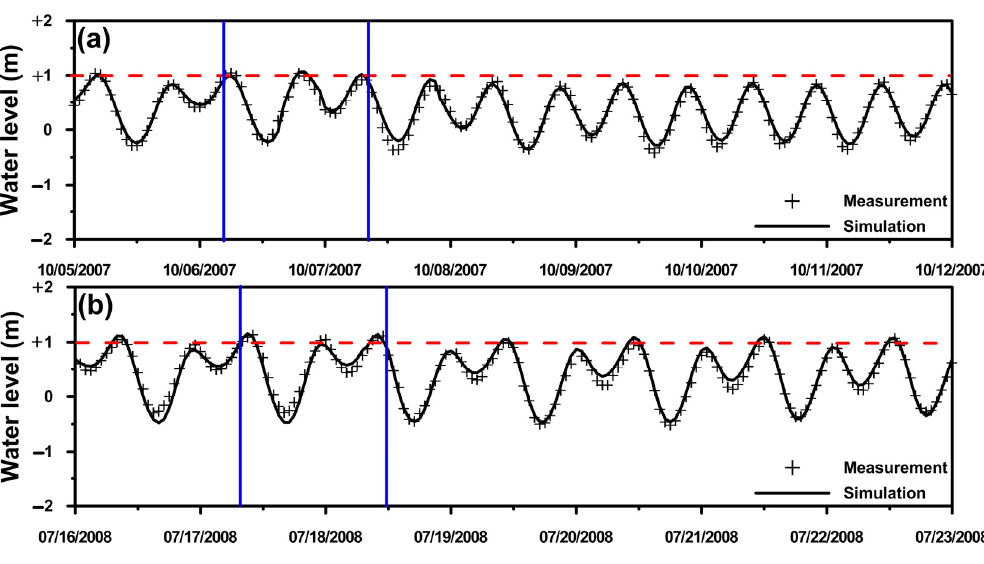
Figure 5. Comparison of model predictions of water level with observation results at the Jianjung Fish Port for ( a ) Typhoon Krosa (2007); ( b ) Typhoon Kalmaegi (2008); and ( c ) Typhoon Morakot (2009). The blue interval represents the period of storm